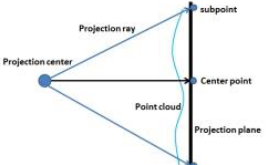
Figure 1.The point cloud is projected to the plane by the central projection